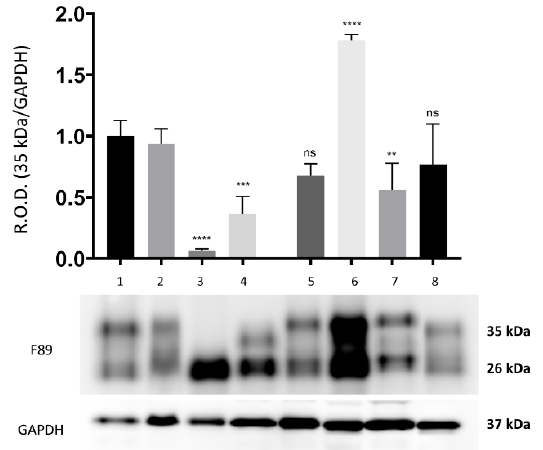
Figure 2. Representative WB analysis of the 35 kDa and 26 kDa bands obtained with the anti-PrP MAbF89/160.1.5. Brain tissue samples from 8 striped dolphins found stranded along the Italian coastline (lanes 1–8), four of which affected by neurobrucellosis due to Brucella ceti (lanes 5–8). The results of WB analyses carried out on the brain tissue of four control ( B. ceti -negative) striped dolphins found stranded along the Italian coastline (lanes 1–4) are also shown (original Western blot figure is in Figure S2). GAPDH was used as a protein load control. The graph depicts only the optical density of the 35 kDa band. The results are expressed as mean ± SEM ( n = 4). The statistical significance was analyzed by ANOVA Dunnett method, **** p ≤ 0.0001, *** p ≤ 0.001, ** p ≤ 0.01, ns p ≥ 0.05 vs. the striped dolphin negative control specimens.